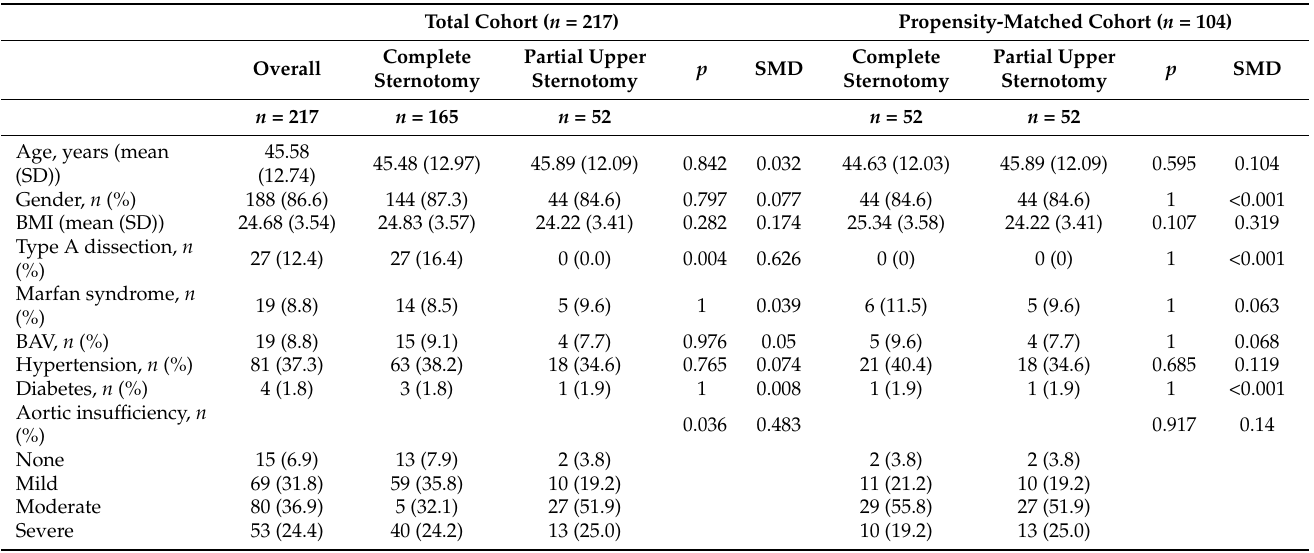
Table 1. Preoperative characteristics of the total cohort and propensity-matched cohorts. Total Cohort ( n =